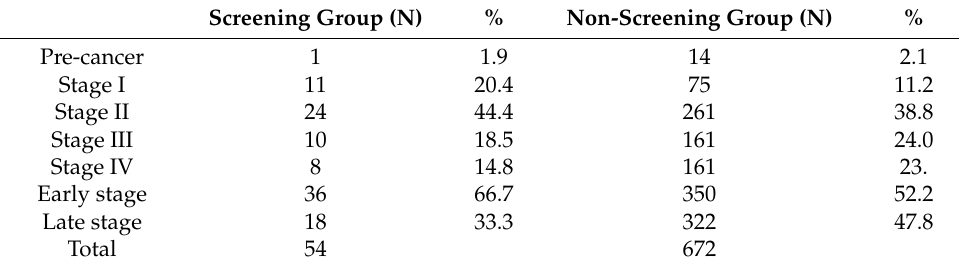
Table 7. The number of various stages in screening and non-screening